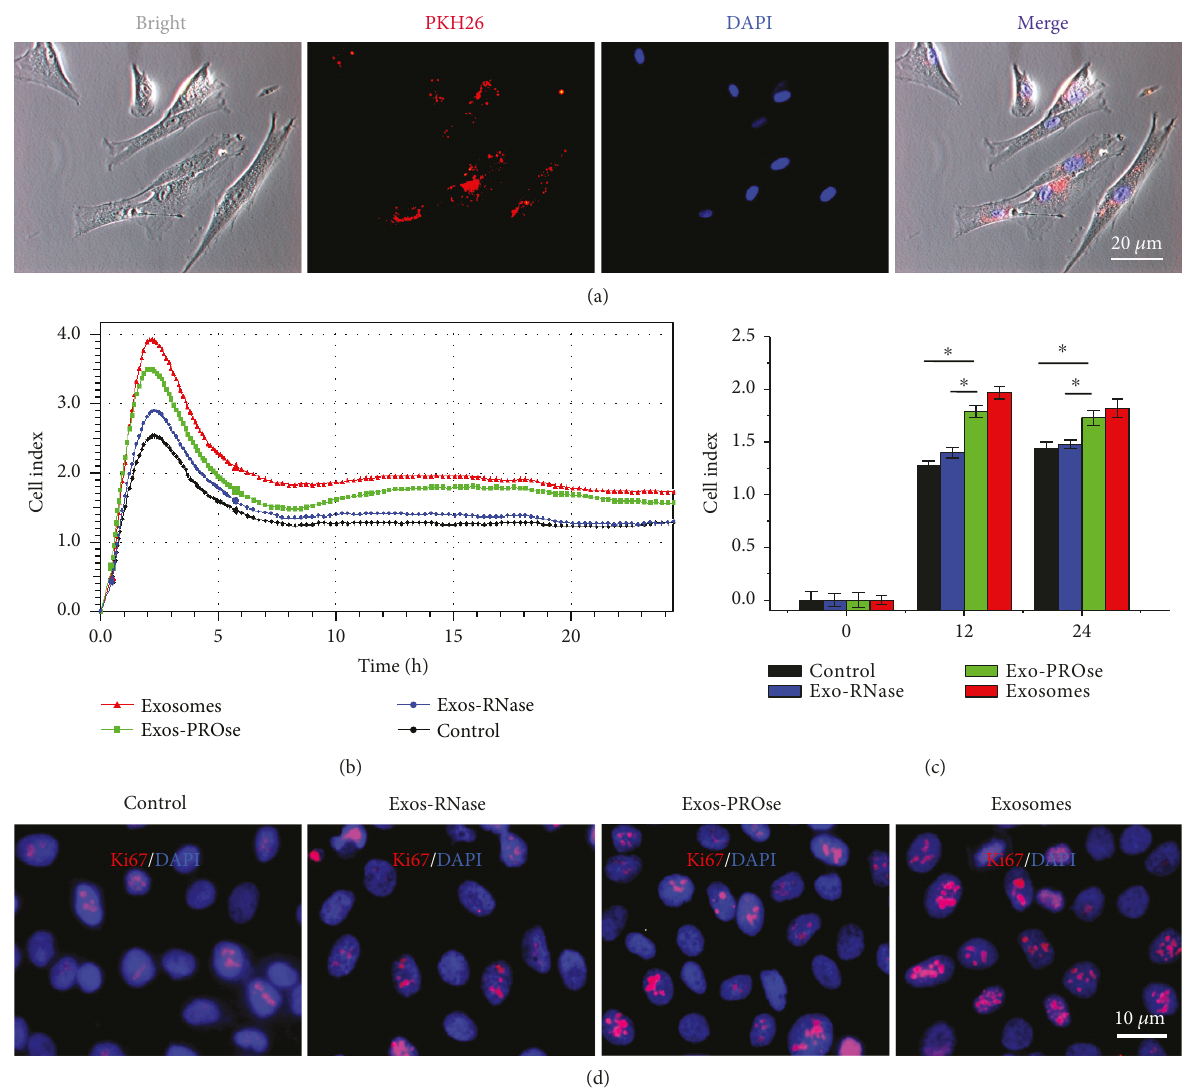
Figure 3: E ff ects of hAEC-Exos on the proliferation of fi broblasts. (a) Fluorescent microscopy analysis shows that PKH26-labeled hAEC- Exos were internalized by fi broblasts. Nuclei were counterstained with DAPI. Scale bar =20 μ m. (b) The evaluation of fi broblast proliferation after di ff erent hAEC-Exos treatments by the iCELLigence system. Each group was assessed in triplicate. Fibroblasts without any treatment serve as control. (c) Quantitative analysis of fi broblast proliferation at 12 h and 24 h. (d) Fluorescent microscopy analysis of ki67 immunostaining (red). Nuclei were counterstained with DAPI. Scale bar =10 μ m. ( ∗ P < 0 05 , n = 3